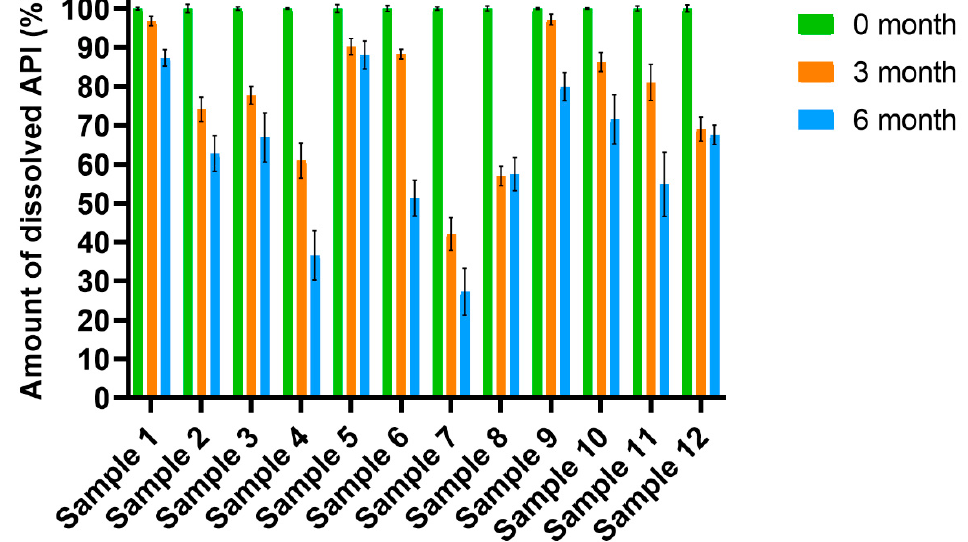
Figure 3. API content for different films during accelerated stability study (Samples 2, 4, 6, 8, 10, 12 contain CA) ( n = 6) .